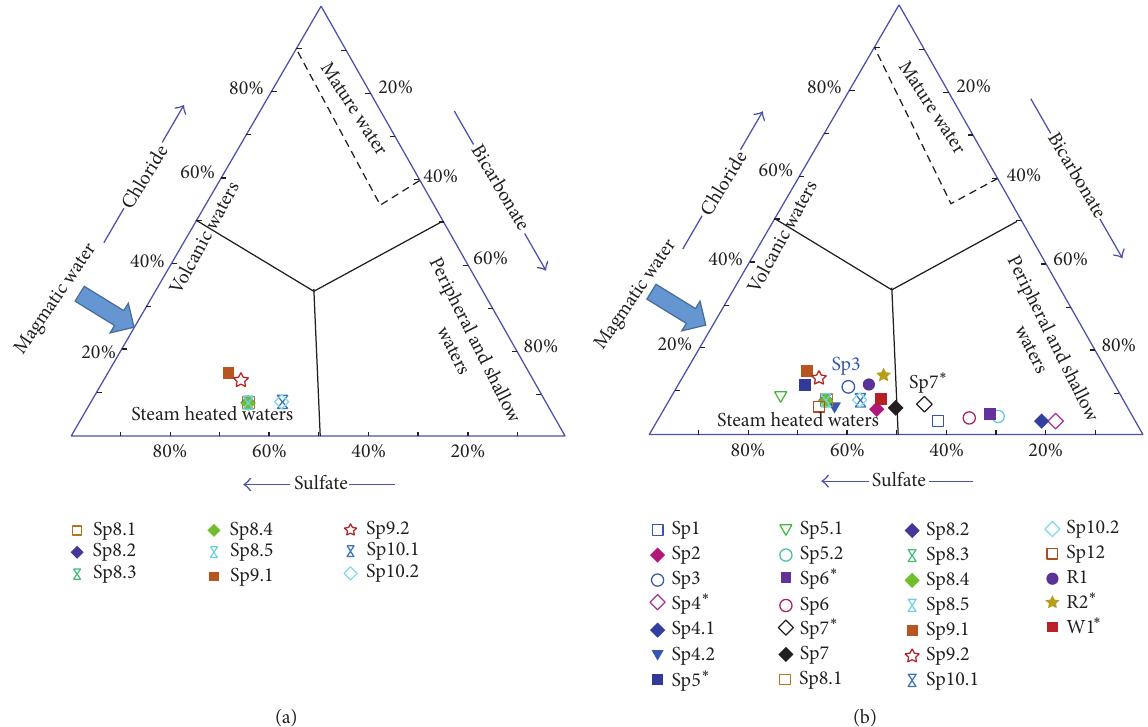
Figure 5: Triangular Cl-HCO 3 -SO 4 diagram that detects source waters of AP and SH hot springs (a) and other water resources (b) in study area.